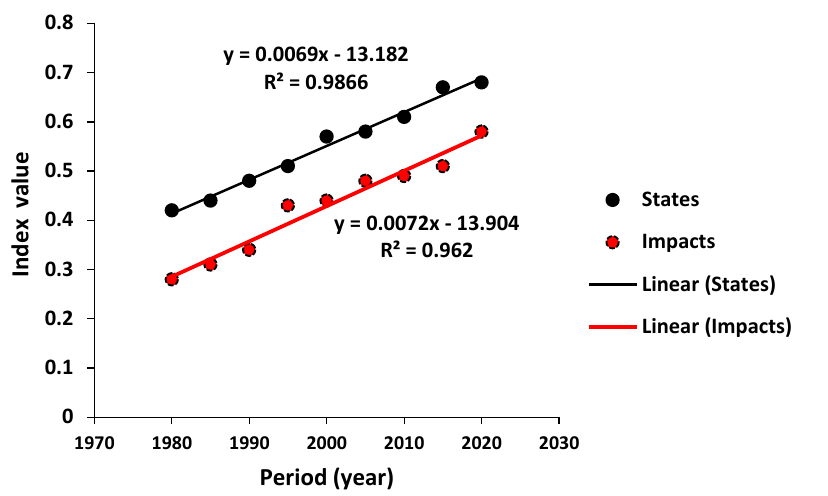
Figure 7. Inter-annual variation of the state and impact Figure 7- Inter-annual variation of the state and impact index. The coefficients of linear regression (R squared) for state and impact were above 0.9, (time) and that the current state and impact will continue to increase with time.